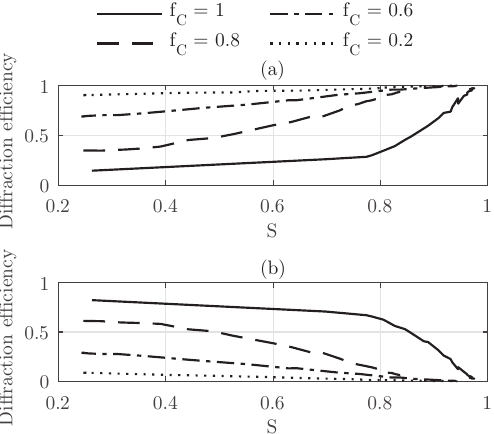
Figure 11. Diffraction efficiencies at the Bragg angle as a function of S for Grating #1 for different values of f C and angle of incidence θ inc = 18.34 ◦ : ( a ) zeroth-order; ( b ) −